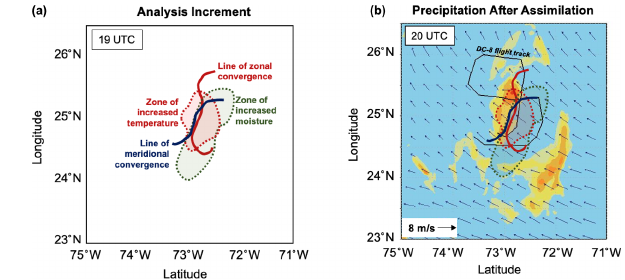
Figure 17. Relating the analysis increments produced by the assim- ilation of the DAWN winds to their impact on the precipitation field. Panels are a zoom-in (75–71 ◦ W, 23–26.5 ◦ N) of the area shown in Figs. 3 and 4. (a) Analysis increments (assimilation–control) as a result of the 19:00UTC assimilation cycle. Marked are the lines of enhanced convergence (zonal in blue; meridional in purple) shown in Fig. 14, and the zone of increased moisture (green) and the zone of increased temperature (red) shown in Fig. 15. (b) Superposi- tion of these same lines and contours onto the precipitation analy- sis at 20:00UTC (representing a 1h model integration from 19:00– 20:00UTC), which was shown in Fig. 4b. The DC-8 flight segment during this time is